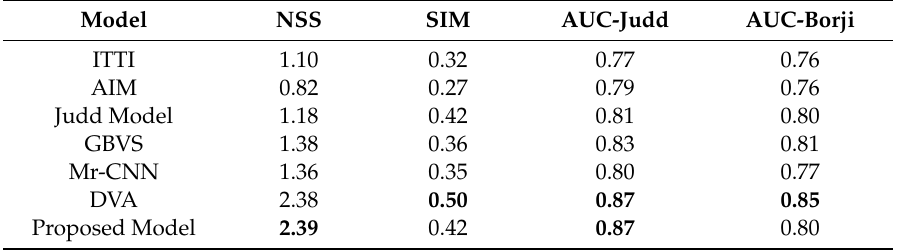
Table 3. Comparison of the quantitative scores of several models for the MIT1003 [31] dataset. Model